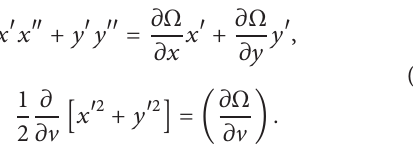
Due to the presence of (1+𝑒 cos V ) in the denominator of